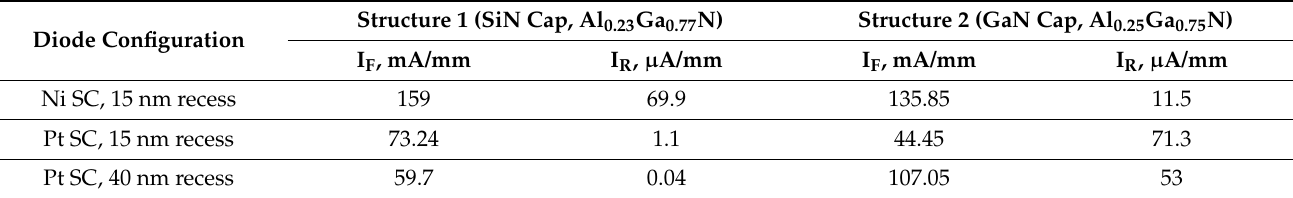
Table 2. Comparison of forward and reverse currents on different types of heterostructures. Diode